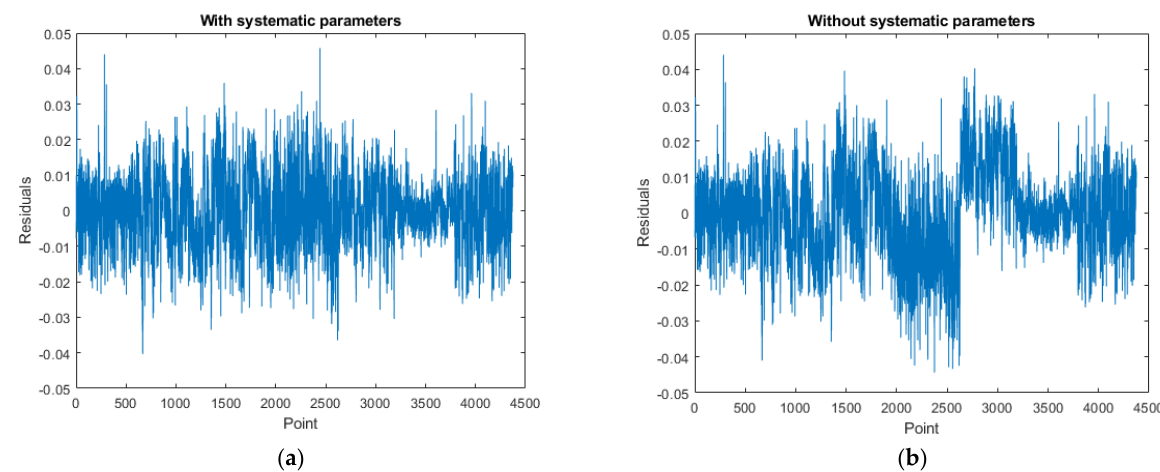
Figure 23. The residual scatter diagram of dataset DATA2. ( a ) with Aps; ( b ) without